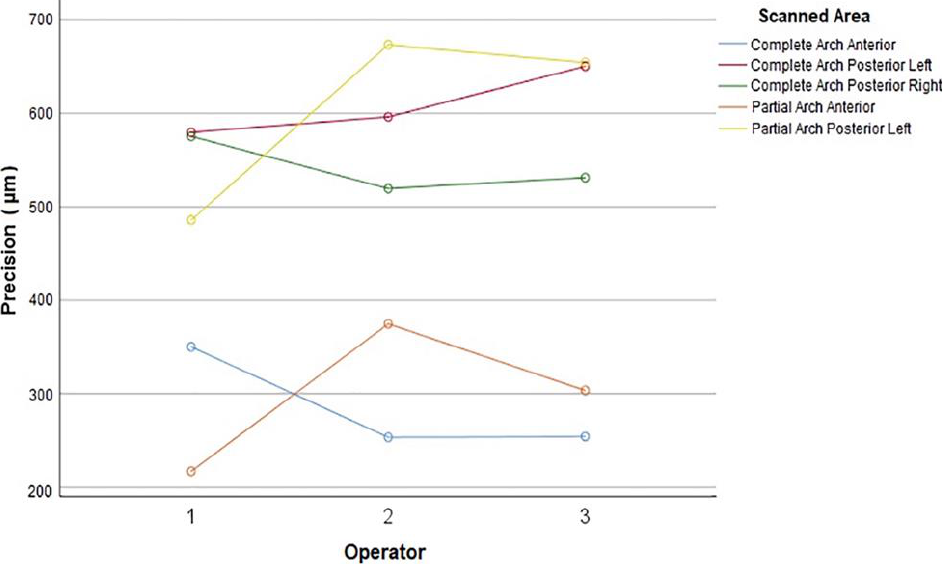
Figure 7. Precision of scans at different sites in complete- and partial-arch scans for each operator.